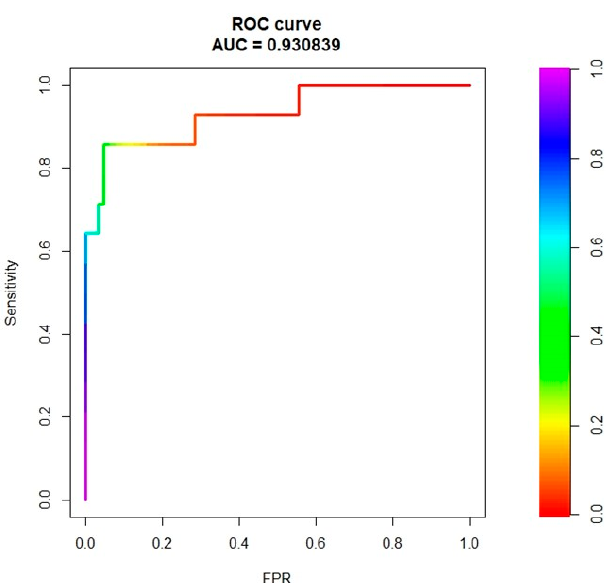
Figure 5. ROC curve analysis referring to the prediction of NASH (yes vs no), considering clinical, laboratory, and radiomic variables for model training.